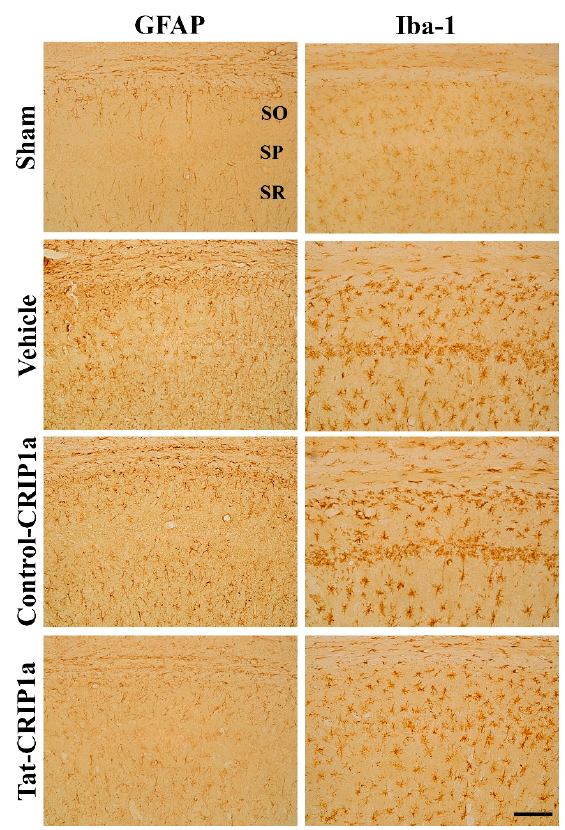
Figure 5. Immunohistochemistry for glial fibrillary acidic protein (GFAP) and Iba-1 in the cornu Ammonis (CA)1 region of the sham, vehicle, Control-CRIP1a, and Tat-CRIP1a groups at 4 days after ischemia. In the vehicle group, GFAP-immunoreactive astrocytes have hypertrophied cytoplasm and processes and ionized calcium-binding adapter molecule 1 (Iba-1)-imunoreactive microglia with hypertrophied cytoplasm with retracted processes. In the Tat-CRIP1a group, astrocytes and microglia with activated phenotypes were markedly decreased. Scale bar = 100 µ m. SO, stratum oriens; SP, stratum pyramidale; SR, stratum